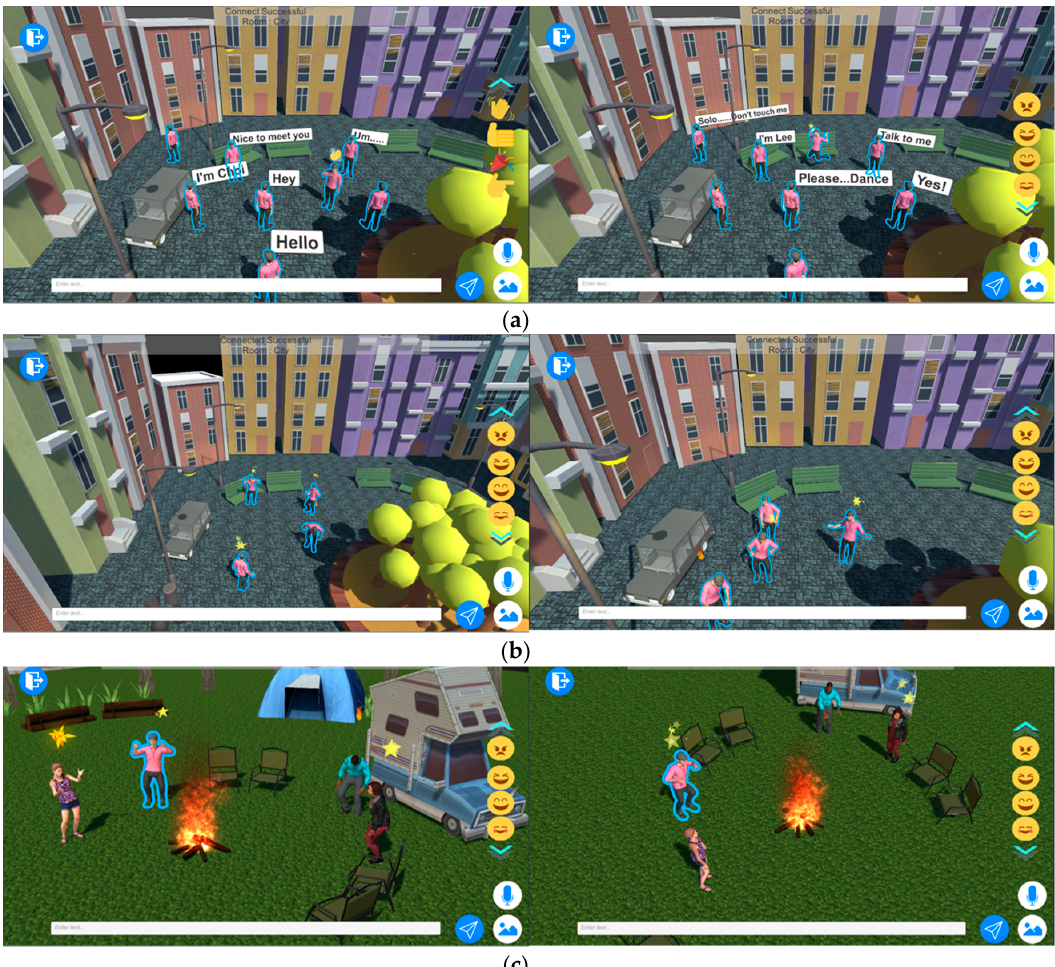
Figure 13. Advantages of AR messenger in our system: ( a ) eight users are accessing at the same time and chatting at the same time. ( b ) Four users are expressing their feelings using emoji. ( c ) Each person is participating in chatting using a different avatar.